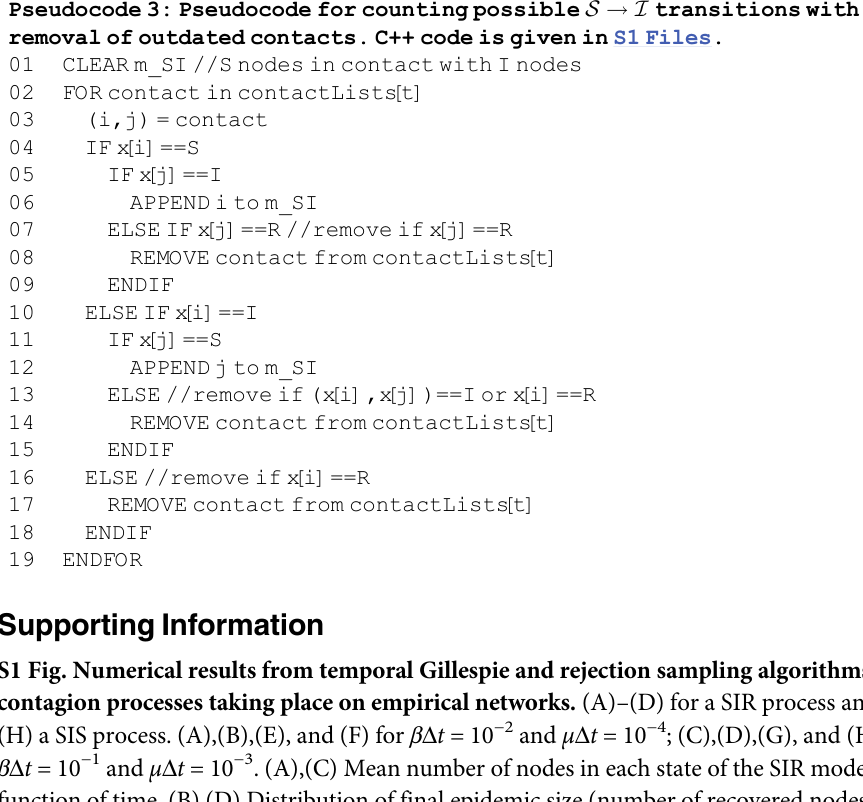
S2 Fig. Comparison of numerical results from temporal Gillespie and rejection sampling algorithms for high transition probability per time-step. (A) – (D) for a SIR process and (E)